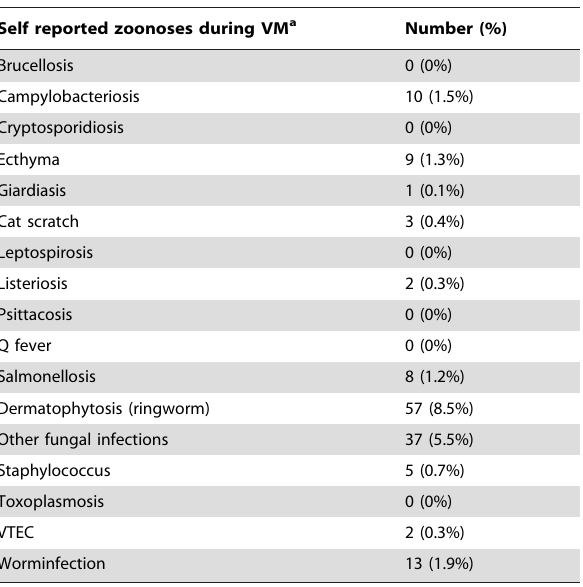
Table 2. Overview of self-reported zoonotic diseases reported by veterinary medicine students (n=960) during the veterinary medicine study.